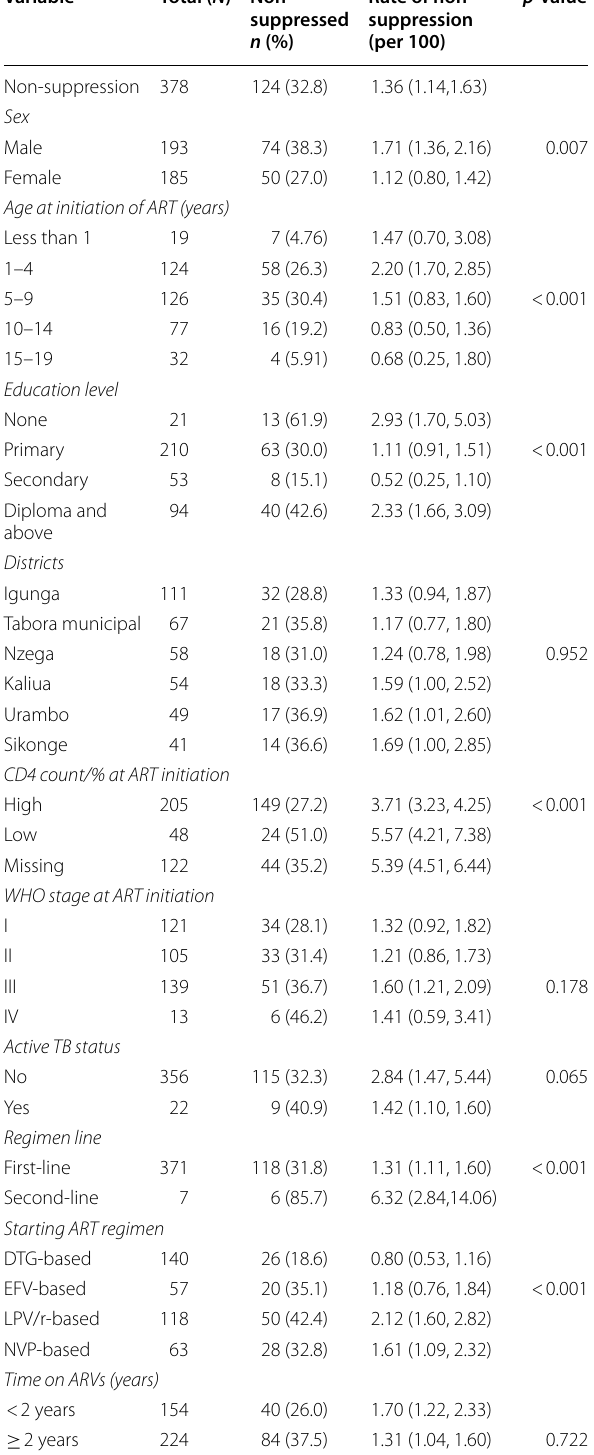
Table 4 Virological suppression among HIV-positive children and adolescents on ART in Tabora region, from January 2018 to April 2022 ( N =